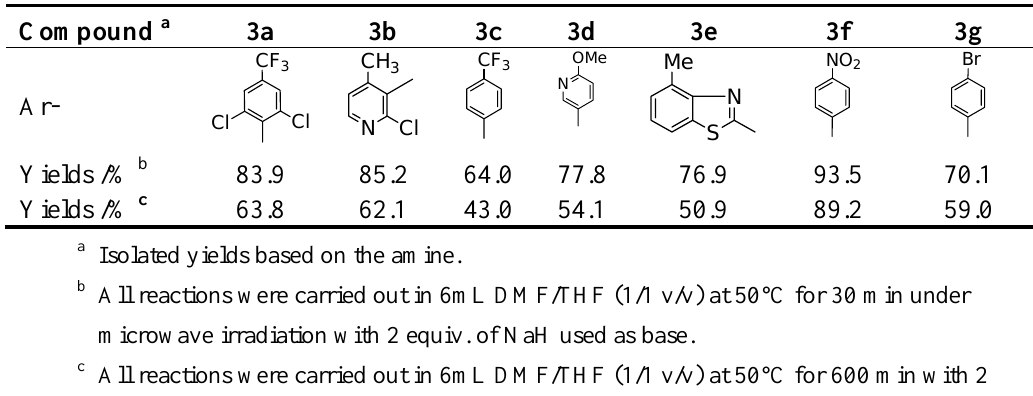
Table 2 . Yields of the title compounds 3